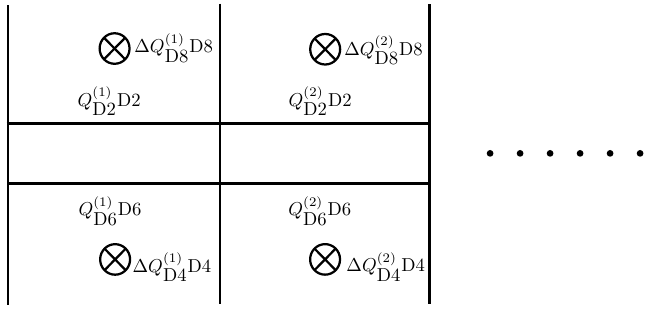
Figure 2 . Hanany-Witten brane set-up associated to the AdS 3 solutions